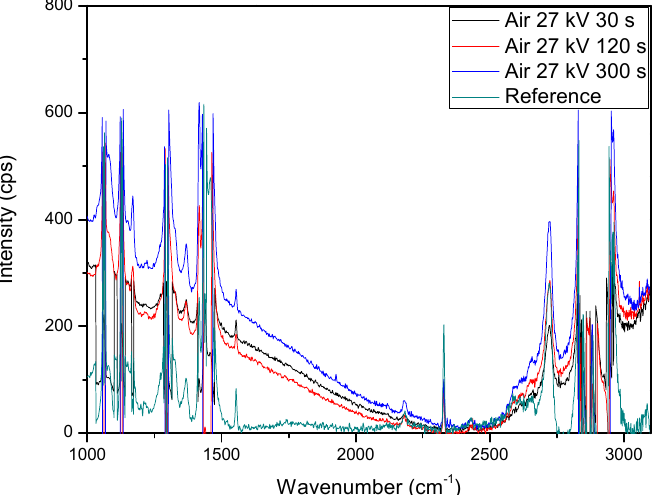
Figure 12. Comparison of treated samples to an untreated sample that have undergone 10 days of degradation to show the presence of fluorescence due to organic matter adhesion on the sample surface after plasma treatment with ambient air.